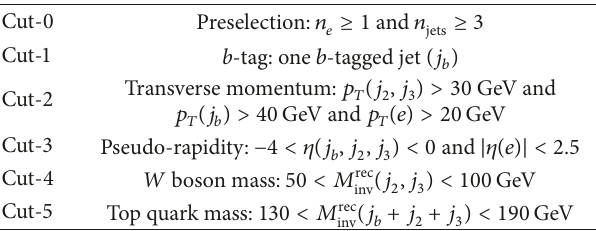
LHeC Table 3: The preselection and a set of cuts for the analysis of signal and background events at